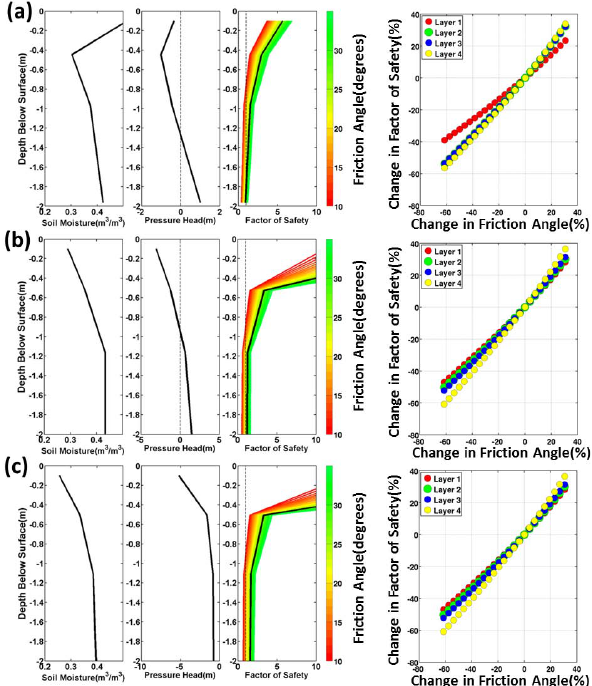
Fig. 17. Sensitivity analysis of the vertical profile of FS to the com- bined cohesion for soil and vegetation, for the slope failure cases in the BCB in July of 2011 (a) and JCB in January of 2009 (b) and December of 2009 (c) . The dark line is the actual failure case using the representative cohesion,